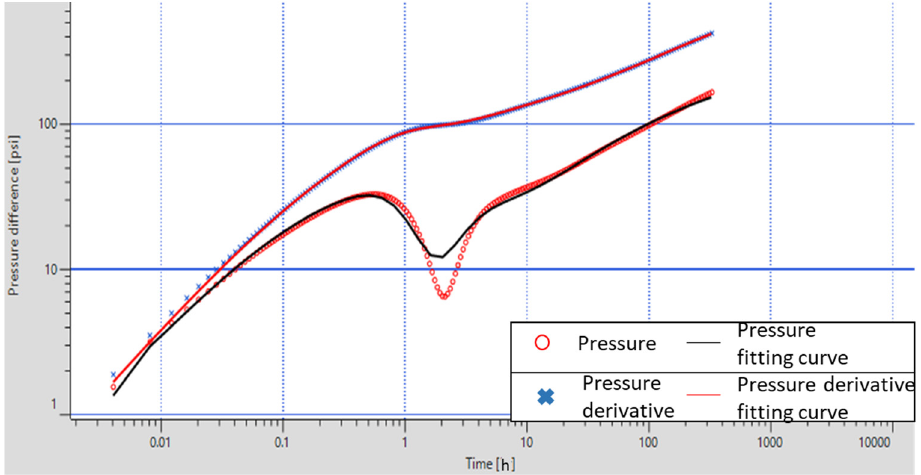
Figure 22. Numerical well test curve of 8 ‐ 5H